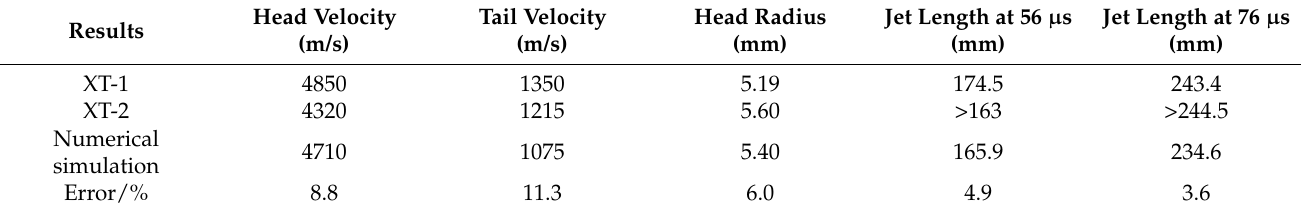
Figure 3. Comparison of numerical simulation and test results over jet formation; ( a ) t = 56 μs; ( b ) t = 76 μs. Table 4. Comparison of jet parameter numerical simulation and X-ray test.